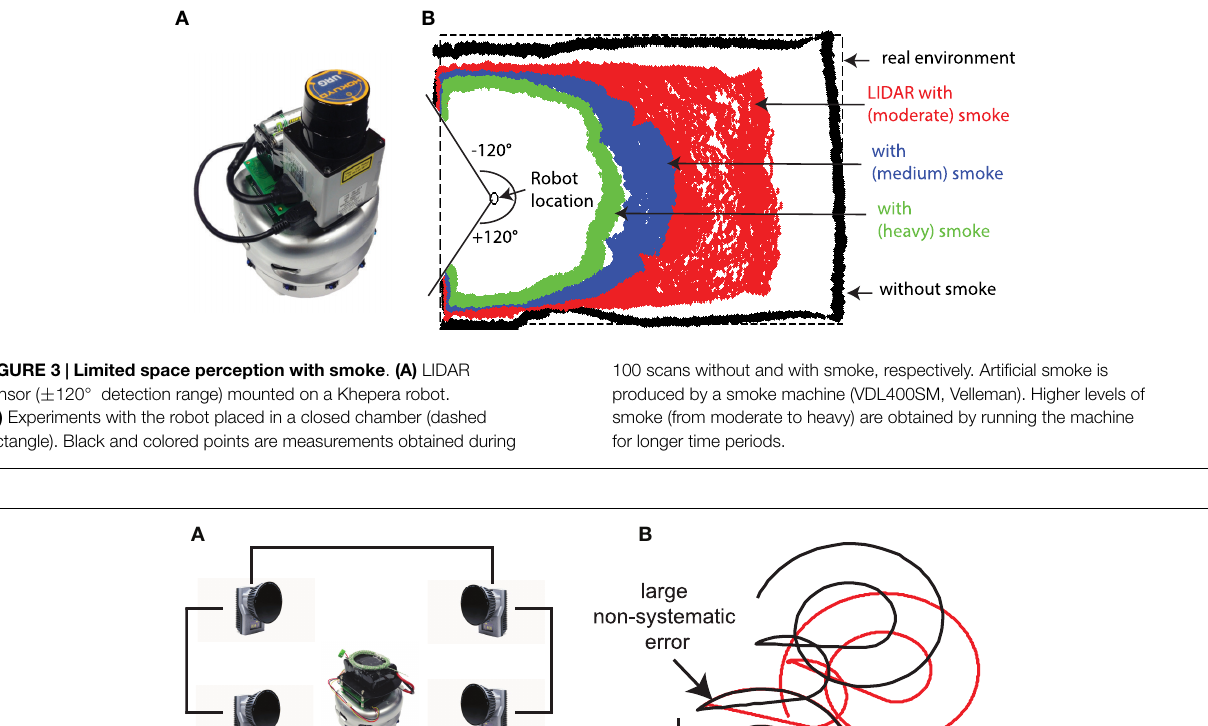
wheels. The trajectory in red is the ground truth measured by the motion capture device (A) . The systematic error resulting from discrete-time integration and/or incorrect parameters in robot kinematics is small. The non-systematic error resulting from wheel slippage (here occurring during the re-orientation phases of the robot) is